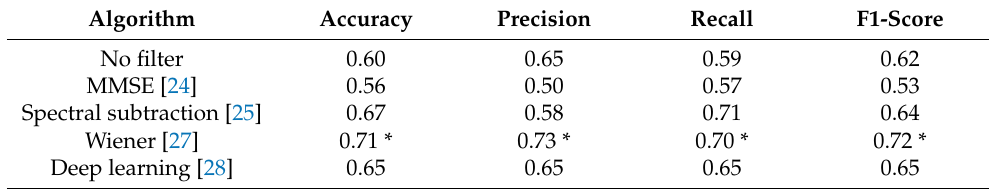
Table 11. Office Noise SNR − 10. * is the best result for each particular measure.